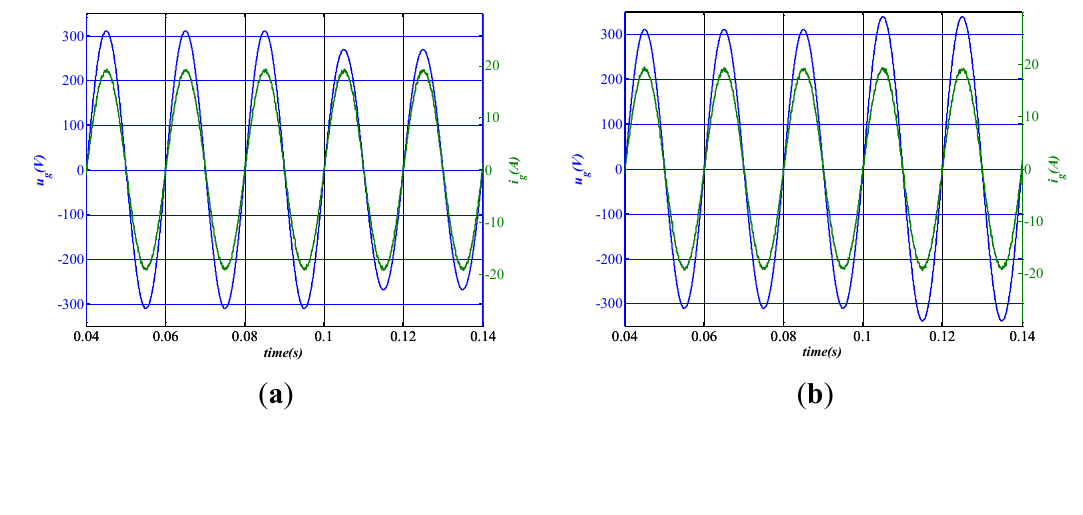
Figure 18. Grid voltage and injected current at full load with capacitor C variation: simulation results. ( a ) Capacitor C increased by 20%: grid voltage sag; ( b ) capacitor C increased by 20%: grid voltage swell; ( c ) capacitor C decreased by 20%: grid voltage sag; ( b ) capacitor C decreased by 20%: grid voltage